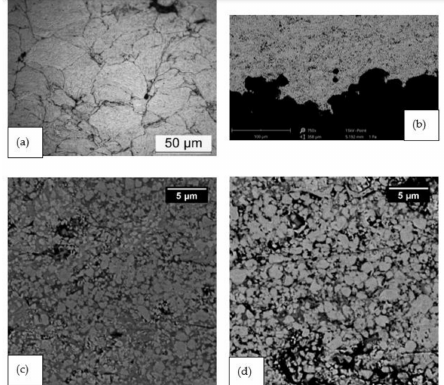
Figure 4. ( a ) OM (optical microscopy) image of CGS MAM maraging after etching. SEM images of ( b ) interface maraging (darker area) and cermet (lighter area); ( c ) WC-12Co, magnification 7500 × ; ( d ) WC-10Co4Cr.